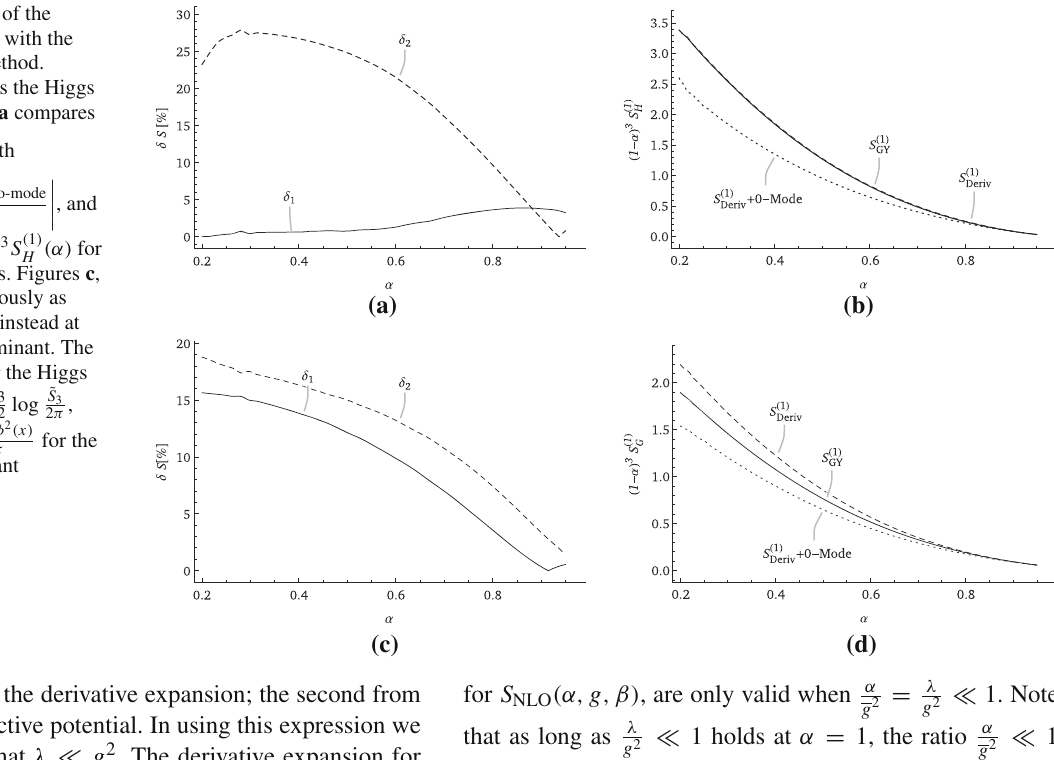
Fig. 1 Comparison of the derivative expansion with the Gelfand–Yaglom